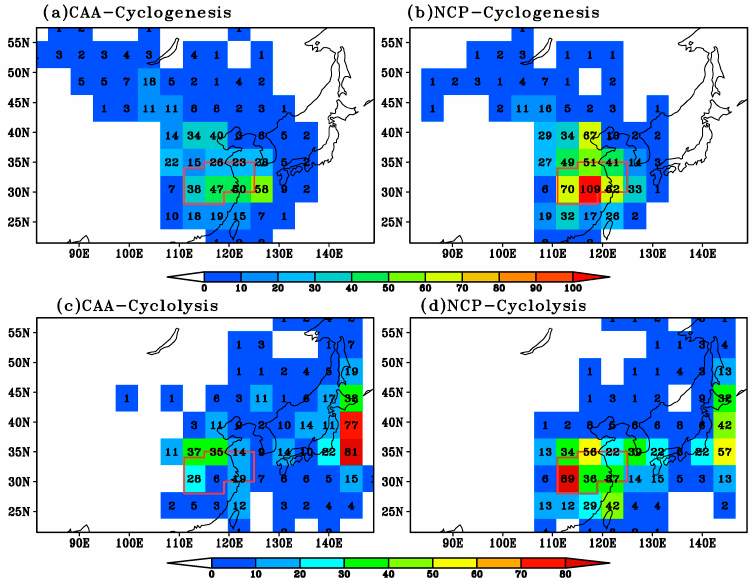
Figure 3. The distribution of the cyclogenesis ( a : CAA; b : NCP) and cyclolysis ( c : CAA; d : NCP) of ICs.